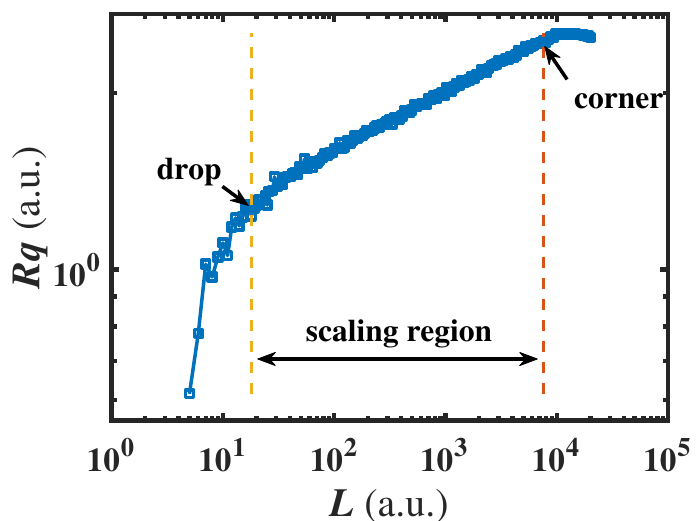
Figure 3. A typical Rq - L curve obtained by the RSE operation with 2-order flattening processing, where D and the sampling length were 1.9 and 20,000,